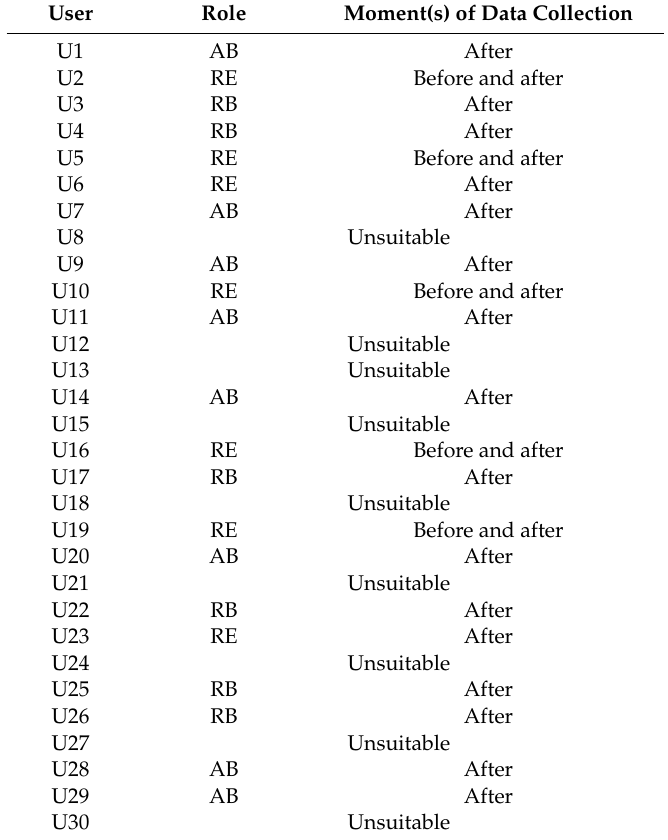
Table 6. Role and moment(s) of data collection of the users selected for the redesign